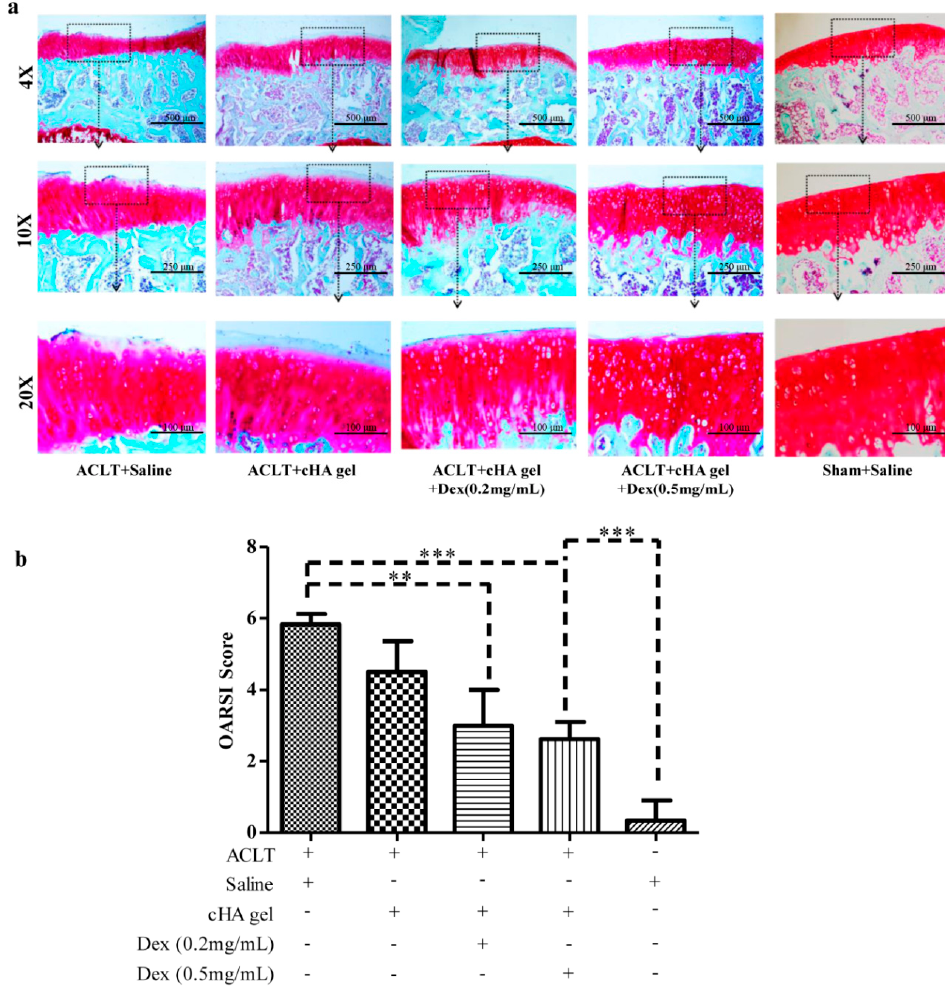
Figure 3. Intra-articular cross-linked hyaluronic acid-dexamethasone (cHA-Dex) hydrogel injections increased the expression of proteoglycan in the microscopic appearance of osteoarthritis (OA) pathology. 6 µm thick histological sections of cartilage from the tibial plateau were stained with Safranin-O/Fast Green. A smoother surface and less blue fibrosis ( a ) was detected in the articular cartilage of the cHA-Dex gel injection animals comparing with the ACLT + saline and cHA only group; ( b ) OARSI histological grading score (mean ± SD) indicated that cartilage damage in the ACLT + saline group was the most severe of all the groups, while cartilage in the sham+saline group had the least damage. Cartilage damage was less in the cHA-Dex (0.2 mg/mL) and cHA-Dex (0.5 mg/mL) gel groups than in the ACLT + saline group. * represents that the difference was statistically significant, ** p < 0.01 and *** p < 0.001. n = 10.